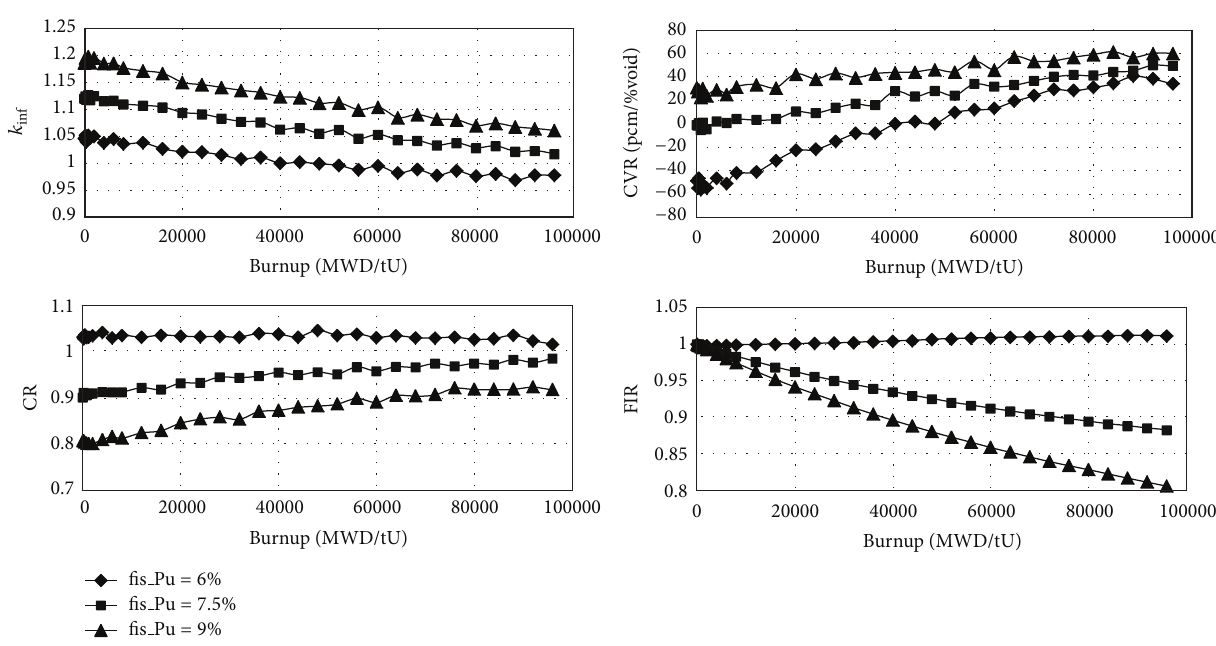
Figure 7: Outer cell burnup performances with DU-MOX